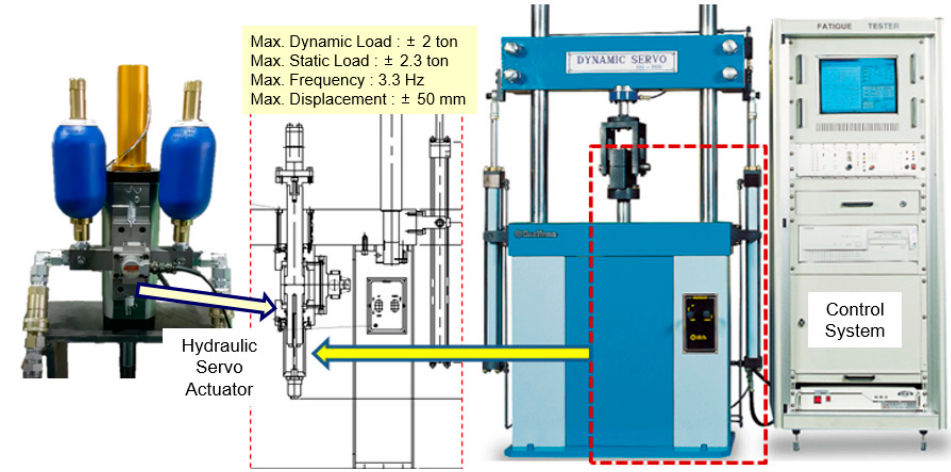
Figure 1. Tensile compression fatigue test equipment.